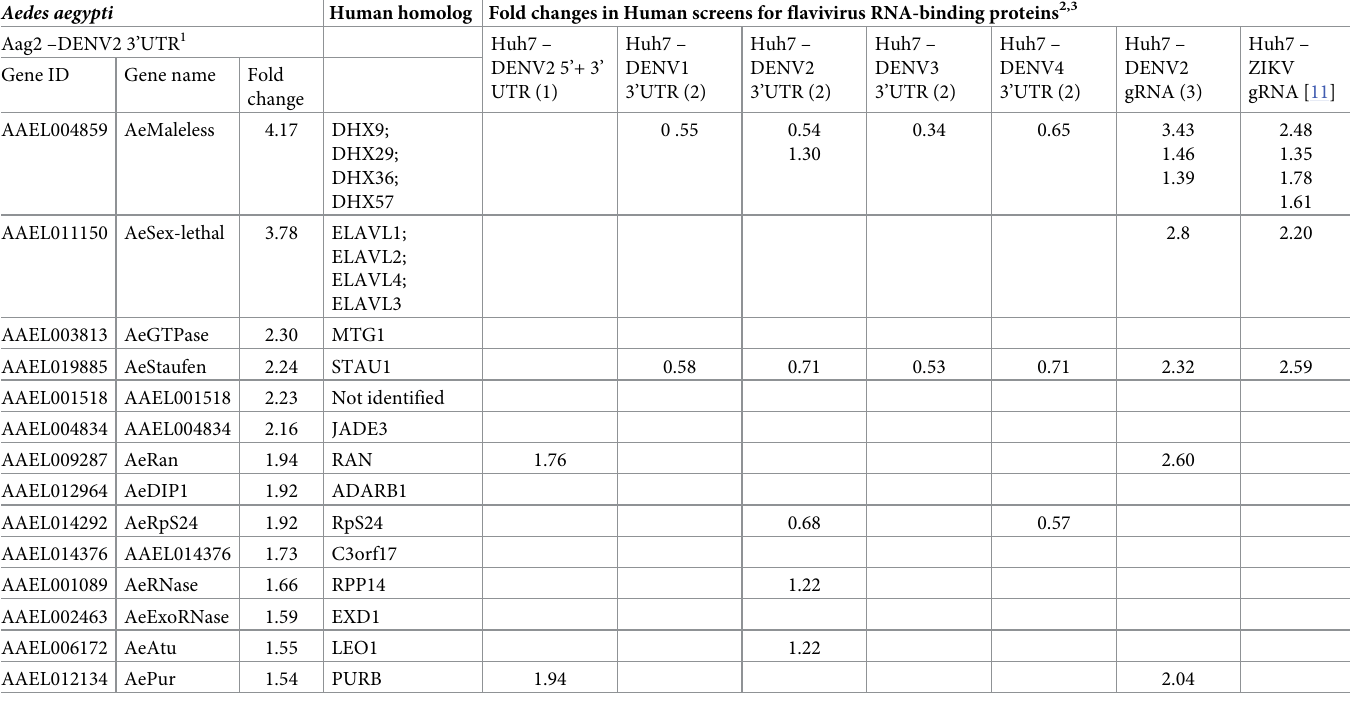
1 Work carried out using RNA-affinity chromatography. 2 Human studies using RNA-affinity chromatography or ChIRP. 3 Cell type and viral fragments used are